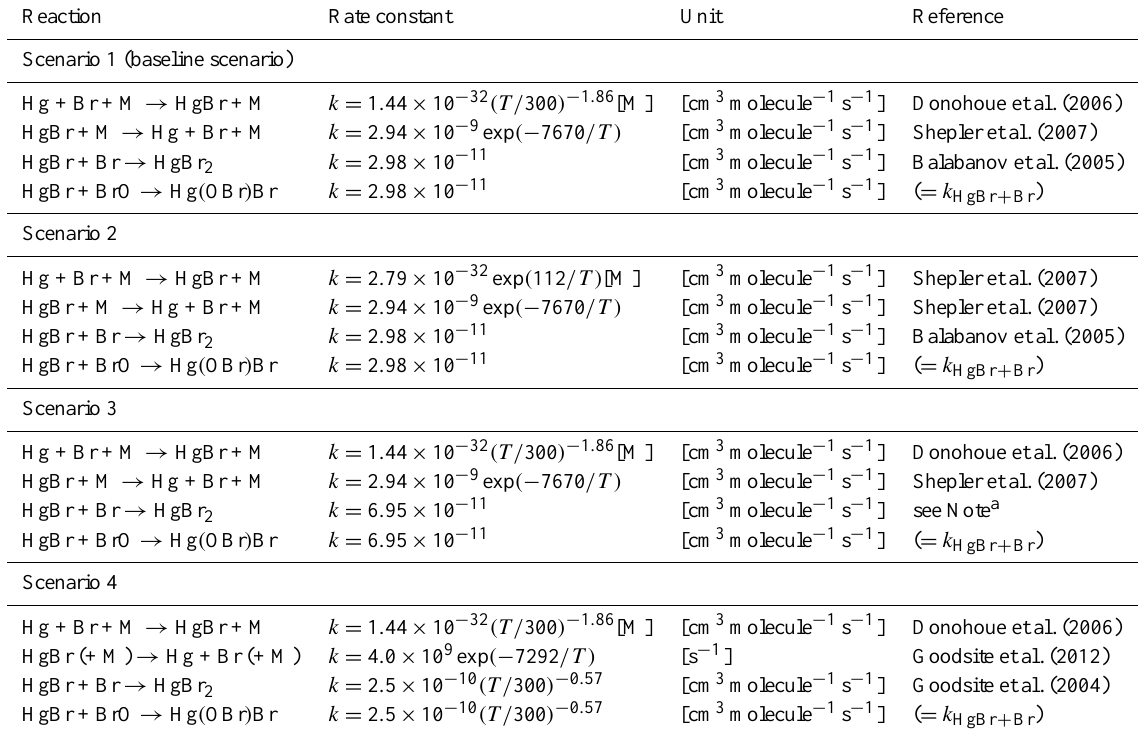
Table 2. List of rate constants for the gas-phase reactions of mercury used in a sensitivity study. See also Table 3 for scenario sub-category. Reaction Rate constant Unit Reference